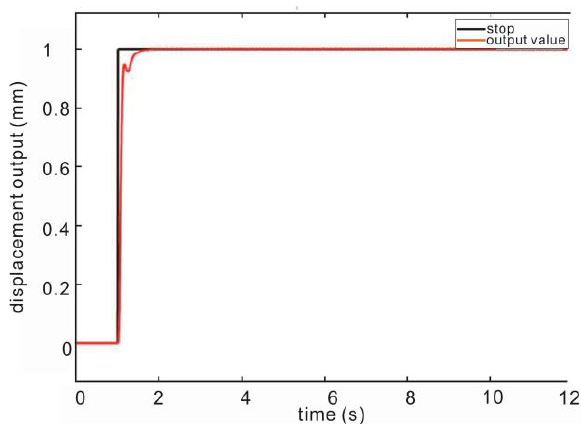
Figure 6. Simulation diagram of step